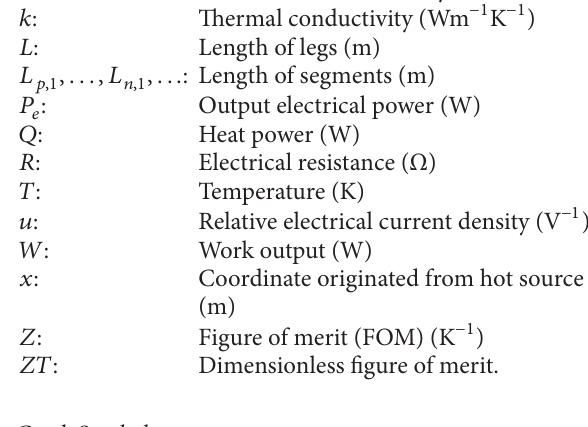
Figure of merit (FOM) (K −1 ) 𝑍𝑇 Dimensionless figure of